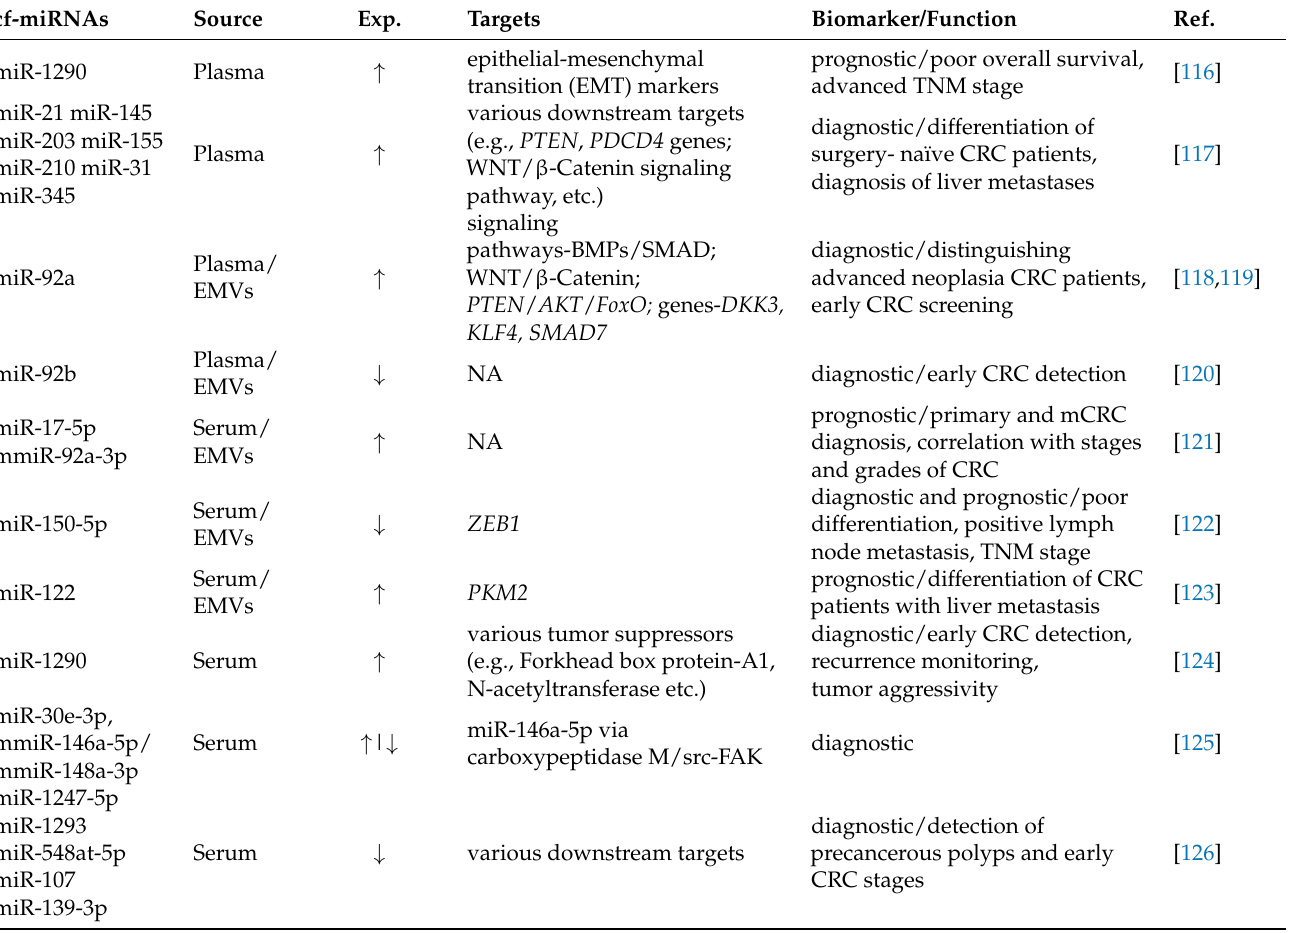
Table 5. List of cf-miRNAs and their role in CRC. Several miRNAs have been present in EMVs that may be extracted from a serum/plasma